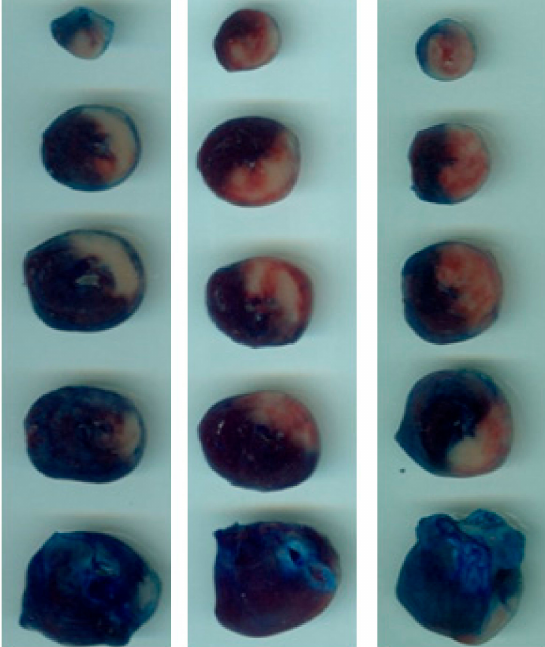
Figure 14. Representative photographs of transversely sectioned Evans-blue perfused, triphenyltetrazolium chloride (TTC)—stained heart tissues, outlining the area at risk (AAR; sum of white and red area); blue, healthy viable tissue; pale white, infarcted tissue. Myocardial infarct area (IS; white) was measured post-myocardial ischemia-reperfusion and TTC staining, in different treated groups and